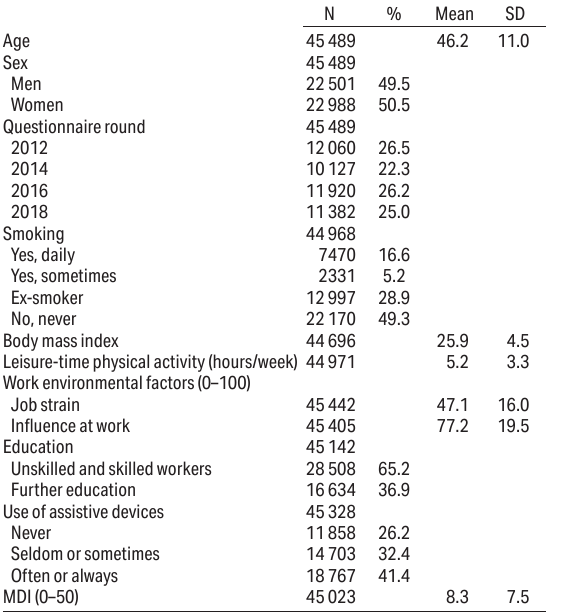
Table 1. Demographics, lifestyle, and work characteristics. [SD=standard deviation; MDI=Major Depression Inventory.]